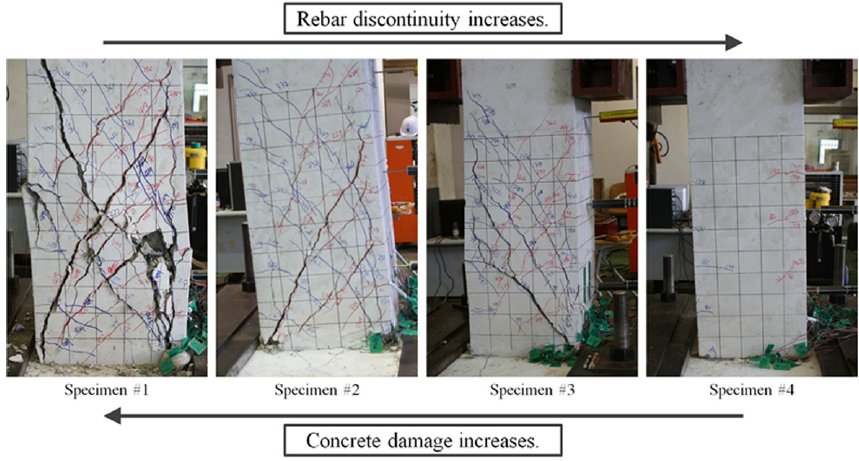
Fig. 19. Degree of deterioration for each specimen versus number of discontinuous reinforcing